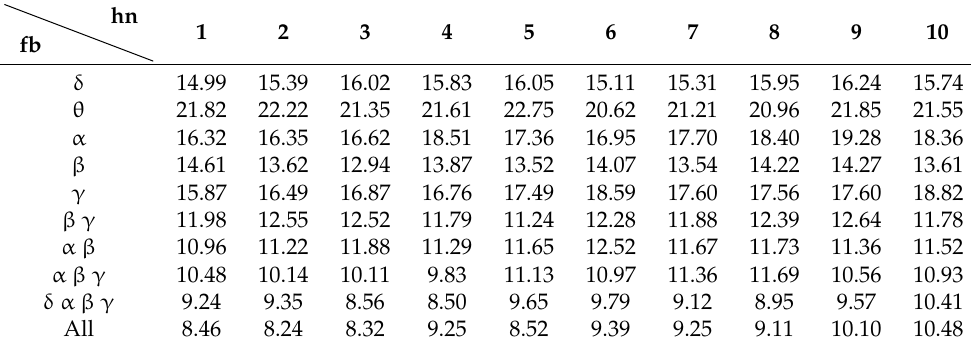
Table 9. The percentage of successful impostor attacks for the second